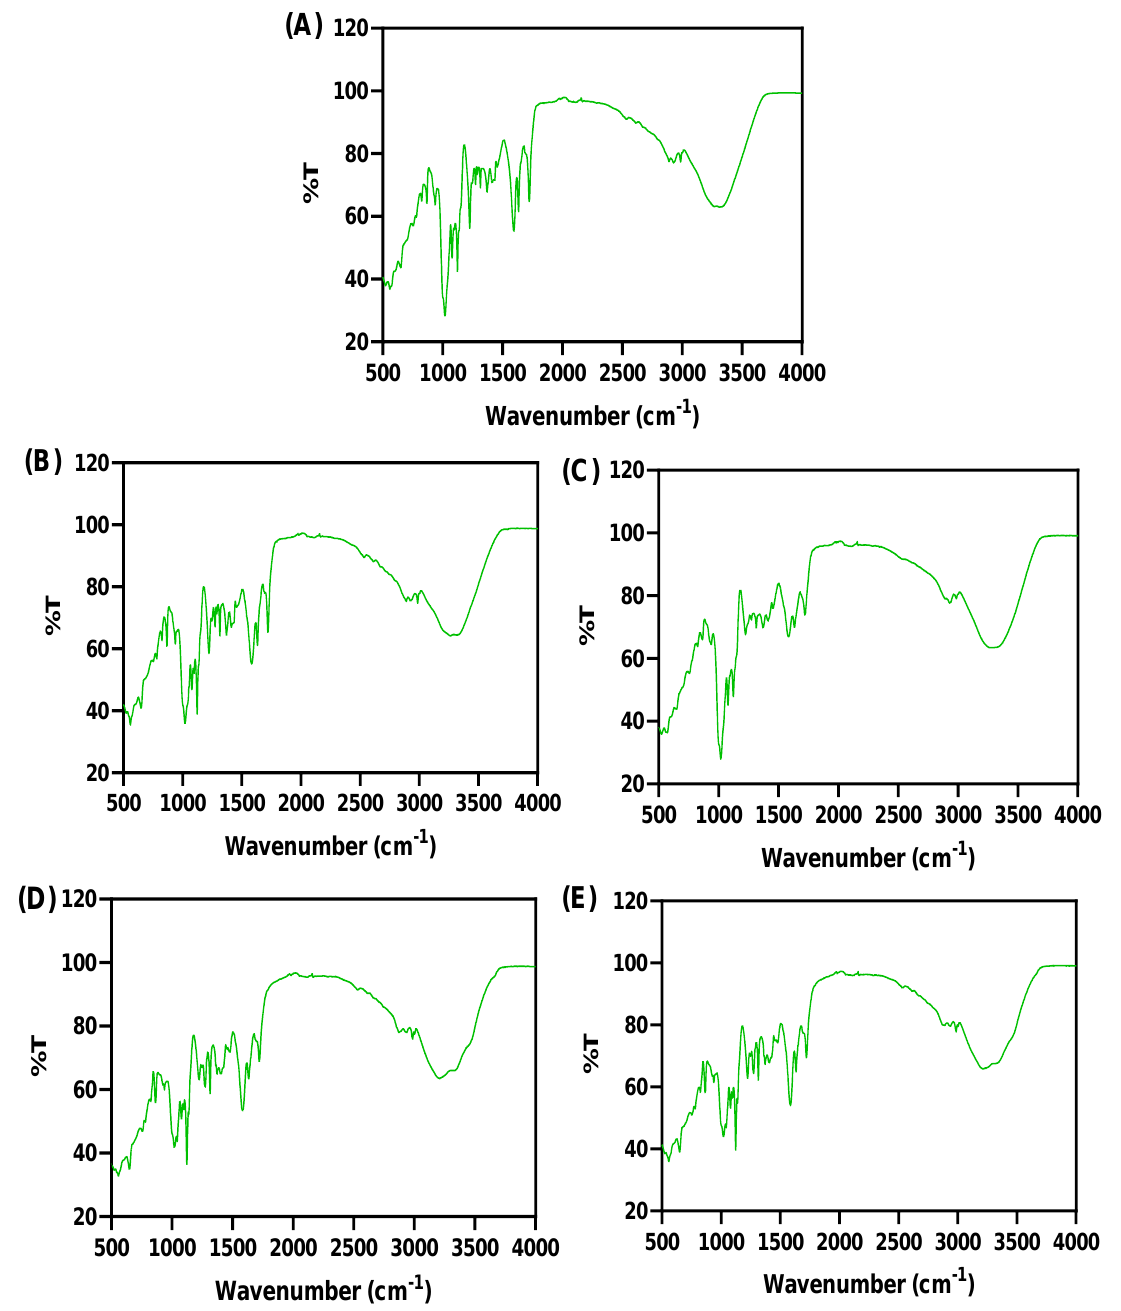
Figure 5. FTIR spectra ( A – E ) of chitosan–NGRS based edible film incorporated with and without EOs. ( A ) represents control film; ( B ) represents garlic oil added film; ( C ) represents galangal oil added film; ( D ) represents turmeric oil added film; ( E ) represents kaffir lime oil added film.